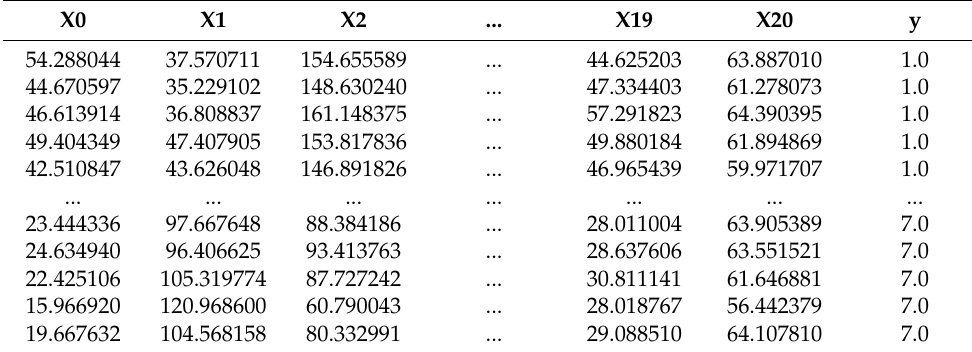
Table 3. Dataset used in the project.